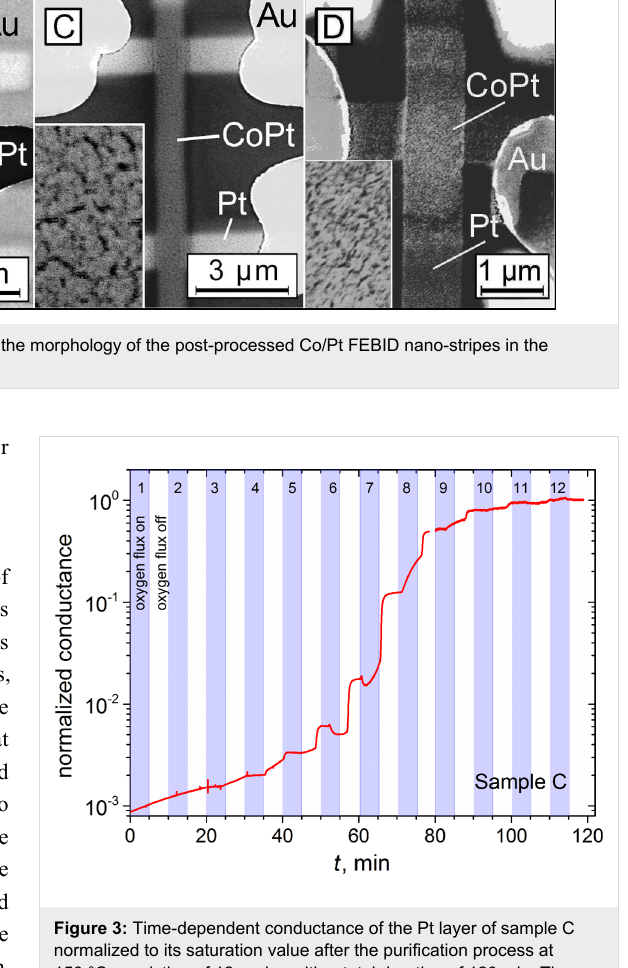
Figure 3: Time-dependent conductance of the Pt layer of sample C normalized to its saturation value after the purification process at 150 °C consisting of 12 cycles with a total duration of 120 min. The filled areas under the curve show the time intervals with the oxygen flux switched